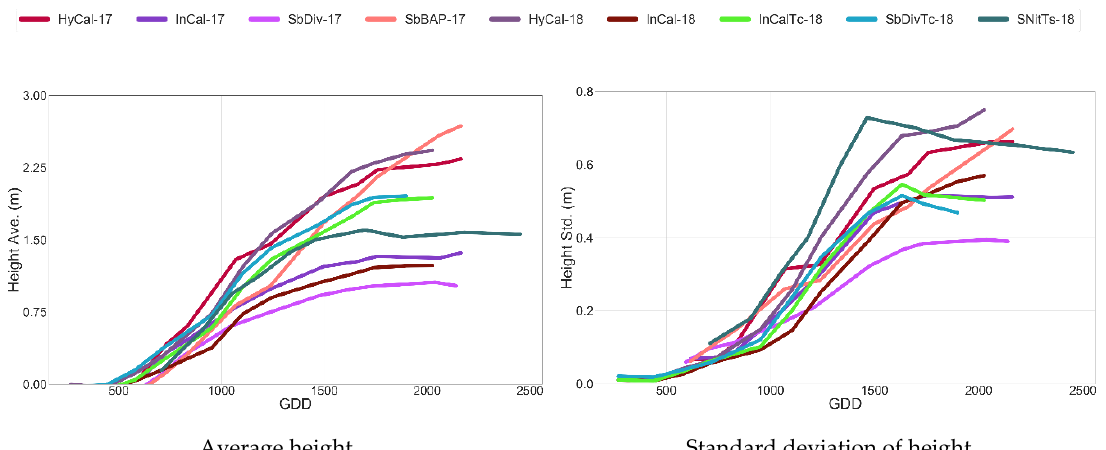
Figure 9. Average and standard deviation of the height of all the plots in each experimental trial in the 2017 and 2018 growing seasons.